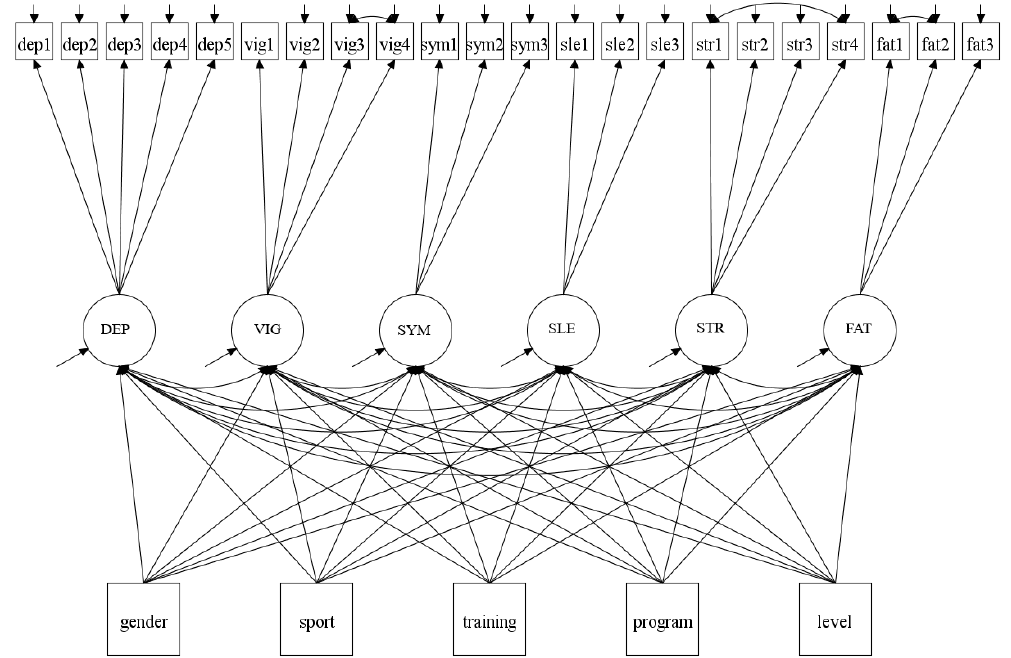
Figure 3. The multiple indicators multiple causes (MIMIC) model, where five covariates affect all the six factors. Gender (1 = male; 2 = female), sport (1 = individual sport; 2 = team sport), hours of training per week (continuous), program (1 = specialization in general studies; 2 = sports and physical education), and school level (1 = first grade; 2 = second grade; 3 = third grade).